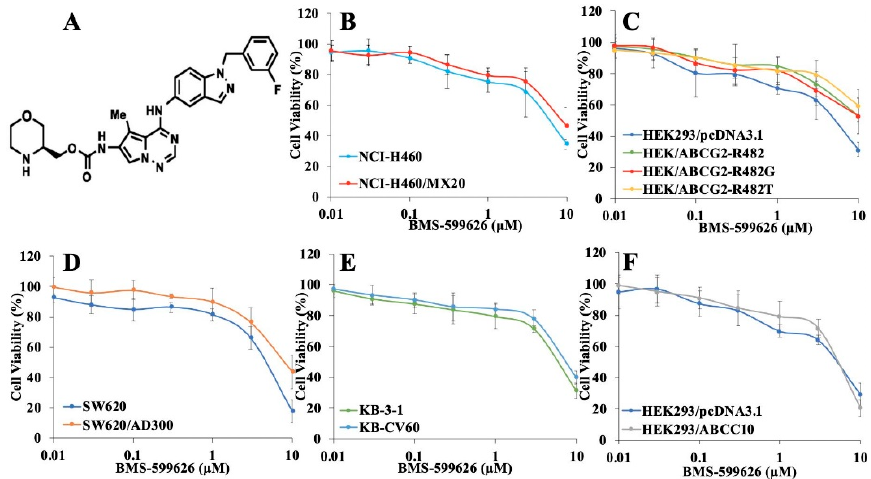
Figure 1. Structure and cytotoxicity curves of BMS-599626 in parental and ABCB1-, ABCG2-, ABCC1-, and ABCC10-overexpressing cells. ( A ) Two-dimensional structure of BMS-599626: [4-[[1-(3-fluorophenyl)methyl]-1H-indazol5-ylamino]-5-methylpyrrolo [2,1-f][1,2,4]triazin6-yl]carbamic acid, (3S)-3-morpholinylmethyl ester, ( B ) cell viability vs. concentration curve of NCI-H460 and resistant NCI-H460/MX20 cells, ( C ) cell viability vs. concentration curve of HEK293/pcDNA3.1 and wild type ABCG2-expressing HEK/ABCG2-R482, and its mutants HEK/ABCG2-R482G, and HEK/ABCG2-R482T cells, ( D ) cell viability vs. concentration curve of SW620 and resistant SW620/AD300 cells, ( E ) cell viability vs. concentration curve of KB-3-1 and resistant KB-CV-60 cells and ( F ) cell viability vs. concentration curve of HEK293/pcDNA3.1 and resistant HEK293/ABCC10 cells. Mean values from three independent experiments are given and error bars indicate SD.